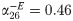
Statistics of SPTs simulated from the reconstructed polymer model.A. Representation of the polymer model described in Fig 5 for TAD D (orange, monomers 1–106). Trajectories for the three loci Linx (monomer 26, red) Chic1 (monomer 62, cyan) and Xite/Tsix (monomer 87, gray). B. MSD of trajectories shown in A for TAD D + E (left, upper) and TAD D alone (left, lower). The anomalous exponents for the three loci are α26 = 0.39, α62 = 0.4, and α87 = 0.31 (TAD D + E), while the anomalous exponent become α26-E=0.46, α62-E=0.4, α87-E=0.43, when TAD E is removed. The histograms of the anomalous exponent (right column) is computed by averaging over 500 realizations with different random connectors positions. C. Box plot of the anomalous exponents (25–75%) computed over 500 realizations by changing the random connectors locations.